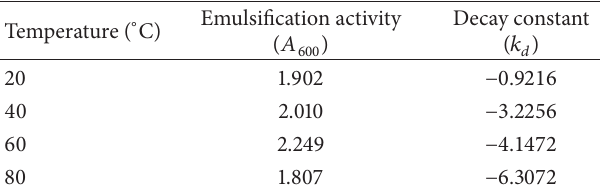
Table 6: Effect of temperature on emulsification activity and stability of